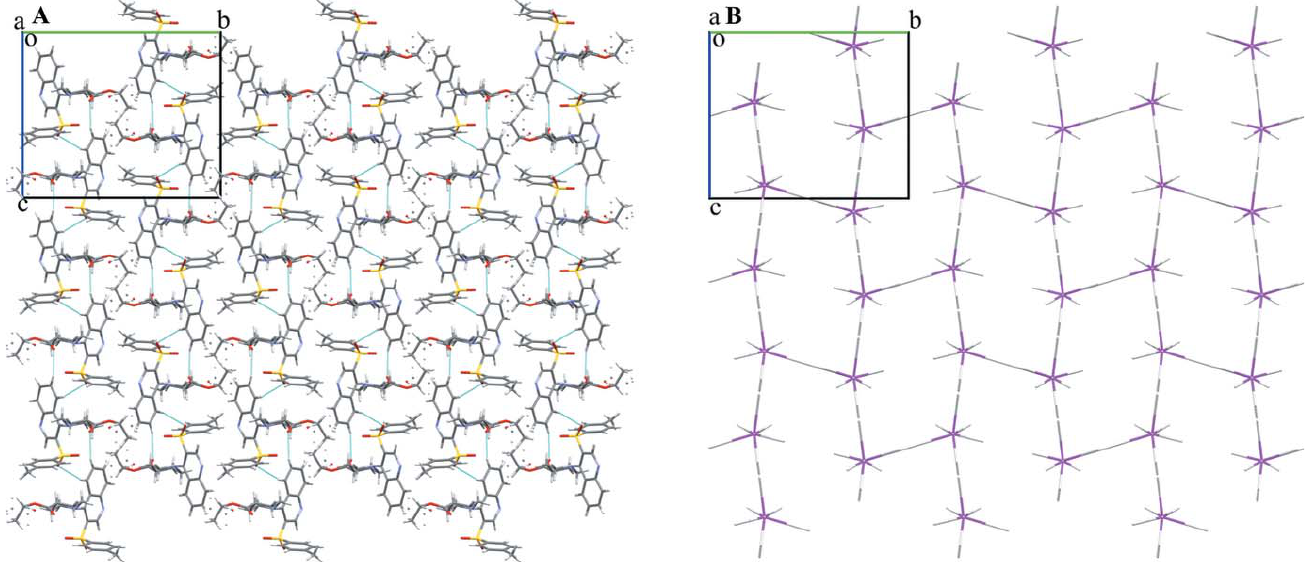
Figure 5 Crystal packing of the molecules ( a ) and energy vector diagrams ( b ). Projection in the [100] direction.